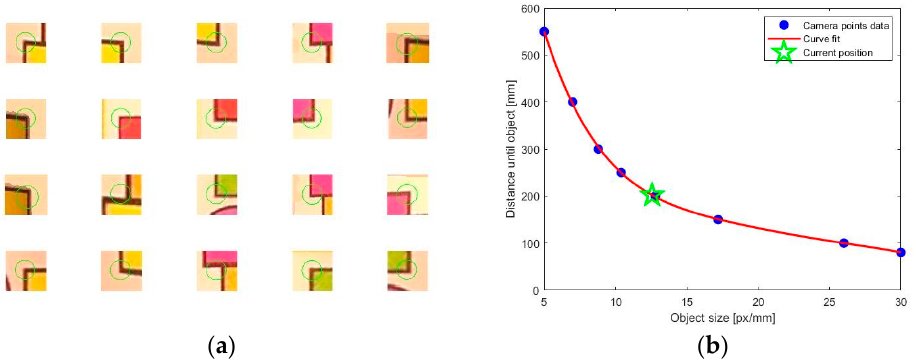
Figure 6. Feature detection and object distance localization on calibration curve. ( a ) 20 features detected; ( b ) localization on calibration curve for an object at a 200 mm distance.